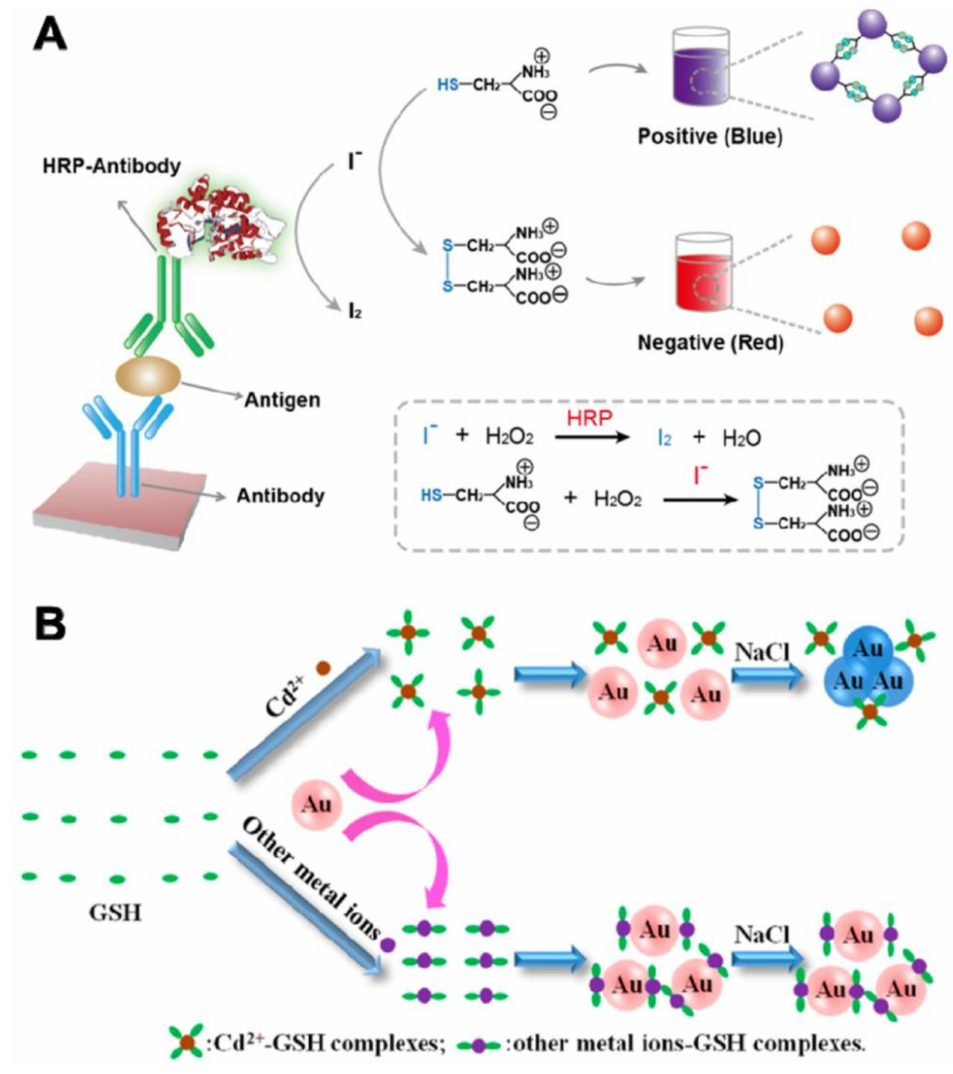
Figure 33. For naked-eye study, amino acids mediated surface-modification of the Au NPs. ( A ) HRP mediated immuno- assay modulation of Au NPs. Iodide catalyzed cysteine oxidation will alter Au NPs’ surface chemistry and influence Au NPs’ aggregation and dispersion. ( B ) The complex of Cd 2+ and GSH can alter surface morphology of Au NPs and increase stability of the citrate-Au NPs at change in concentration of NaCl. Adapted with permission from reference [220]. Copyright 2014,